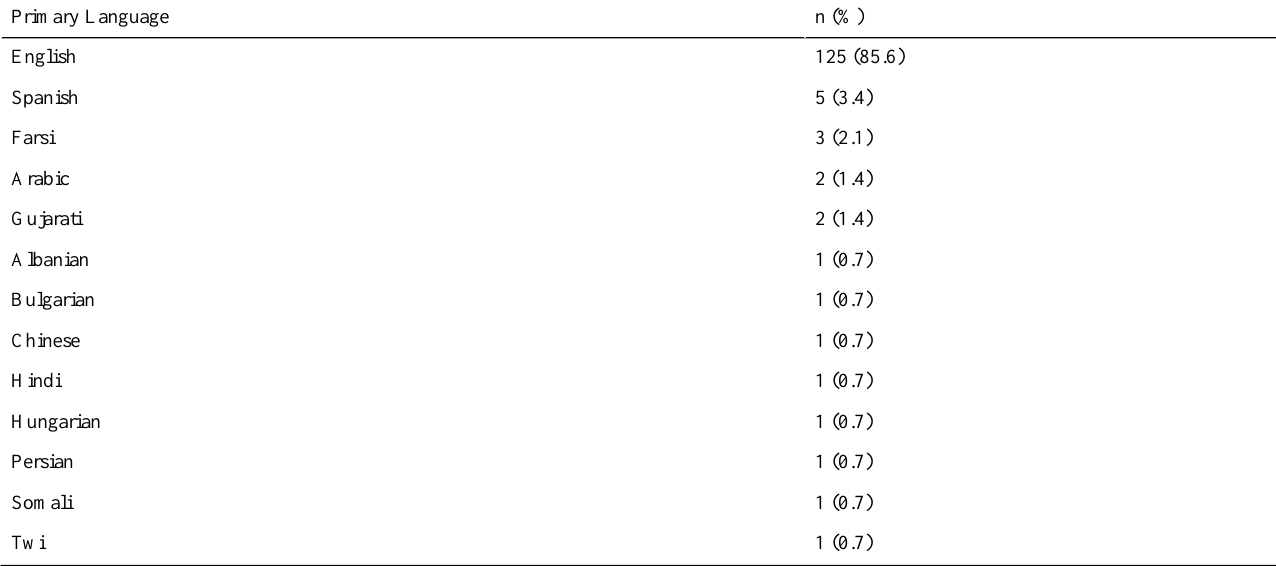
Table 1. Primary language of